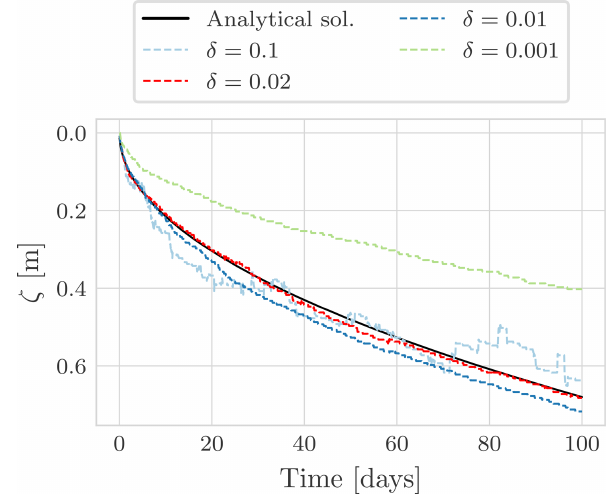
Figure 7. Comparison between the Neumann analytical solution and the numerical solution obtained with the globally convergent Newton algorithm (g. c. N.). All the numerical simulations use the same spatial discretization (cid:49)z = 0 . 005m and a time step size of (cid:49)t = 3600s. This figure shows as the numerical solution depends on the choice of the parameter δ